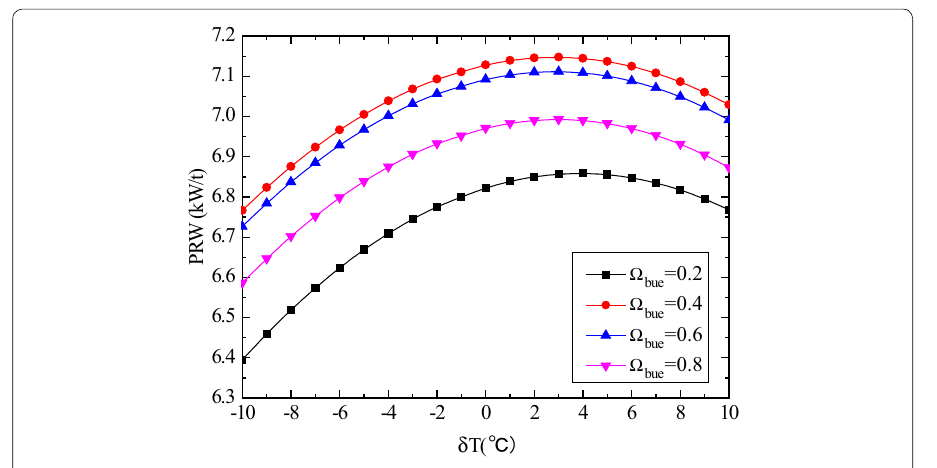
Fig. 11 PRW versus δT with different Ω bue